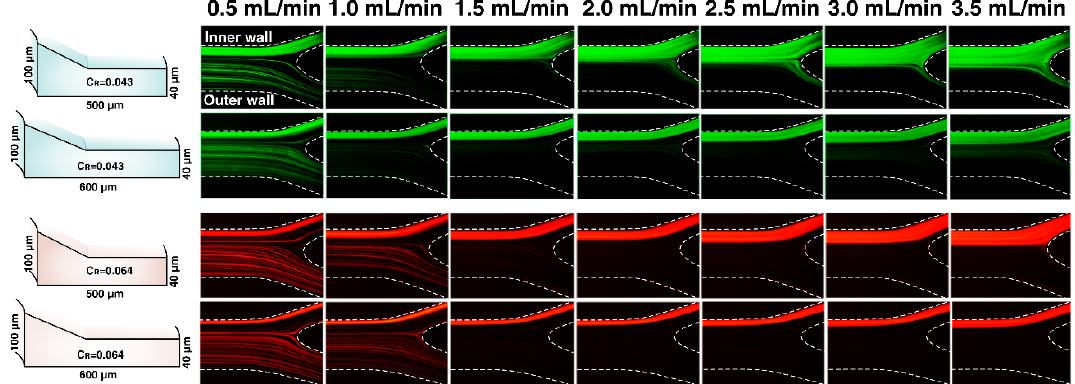
Figure 6. Fluorescent images of the outlet of Design No. 4 and Design No. 5 are shown. Cross-sectional views are given for comparison ( left ). Fluorescent stream images indicate the distribution of 4 µm ( green ) and 6 µm ( red ) at different flow rates. Table 2. The separation efficiency of 4 µm fluorescent particles in a high and low concentration. High Concentration Low Concentration Per mL Total Per mL